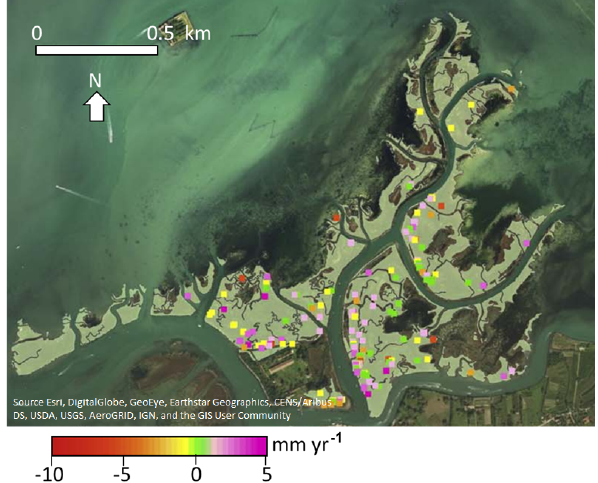
Figure 2. Lazzaretto Nuovo salt-marsh: average land displacement between 2008 and 2013 measured by PSI. Positive values mean up- lift, negative values land subsidence. The red box shows the location of the loading experiment (modified after Da Lio et al., 2018).